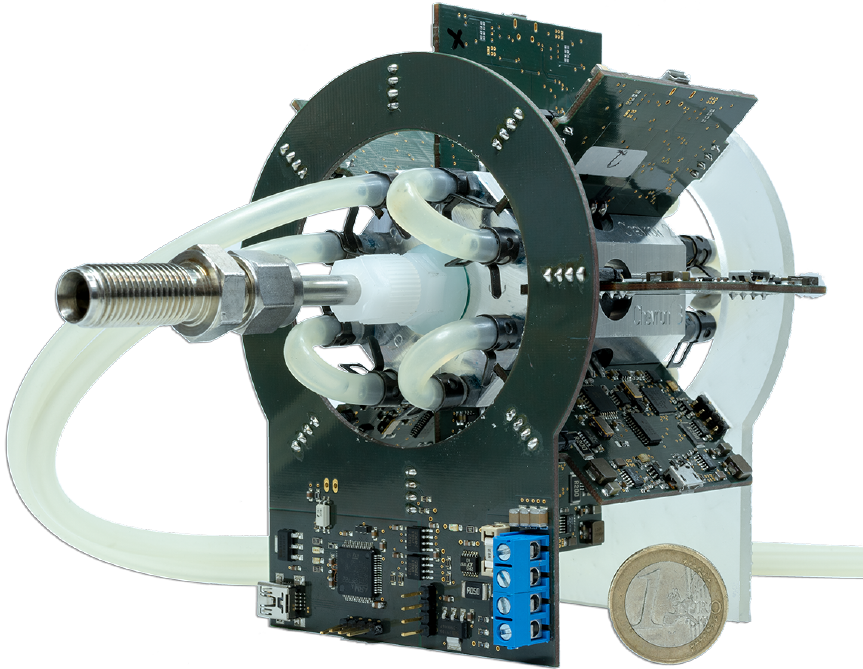
Figure 1. The proposed system attached to a custom-built MOX-Chamber with water